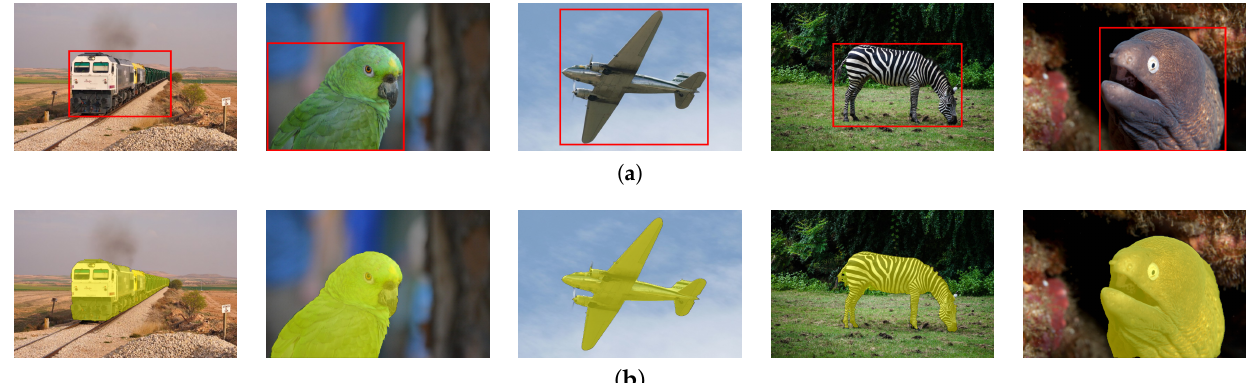
Figure 1. Two different types of annotated images from OpenImage [68]: ( a ) Bounding box annotations; ( b ) Silhouette annotations (in yellowish-green), also referred to as segmentation and pixel-level annotations.